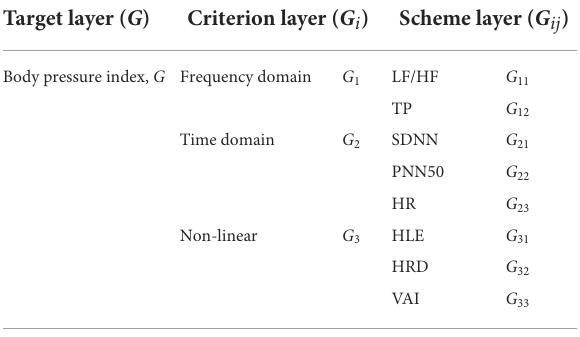
TABLE 1 Pressure indicator